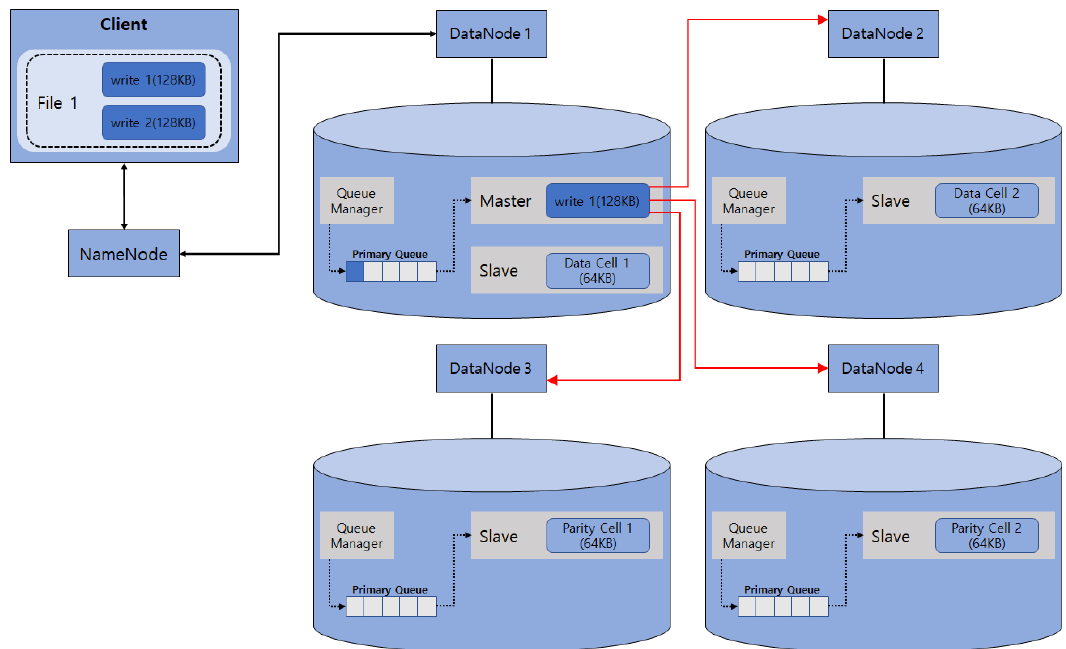
Figure 3. Process of distributing blocks in the EC-based HDFS system.